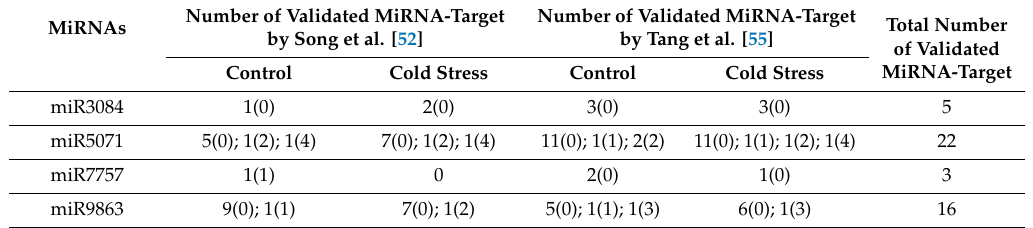
Table 2. Validated targets with P -values less than 0.05 by Degradome data referred from Song et al. [52] and Tang et al. [55]. Number in the parentheses indicate the category of the miRNA-target cleavage. Number of Validated MiRNA-Target MiRNAs by Song et al.